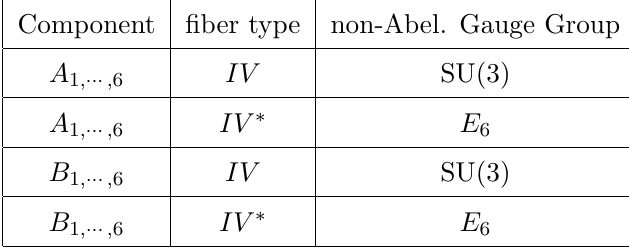
Table 3 . Singular (cid:12)ber types and the gauge groups on the discriminant